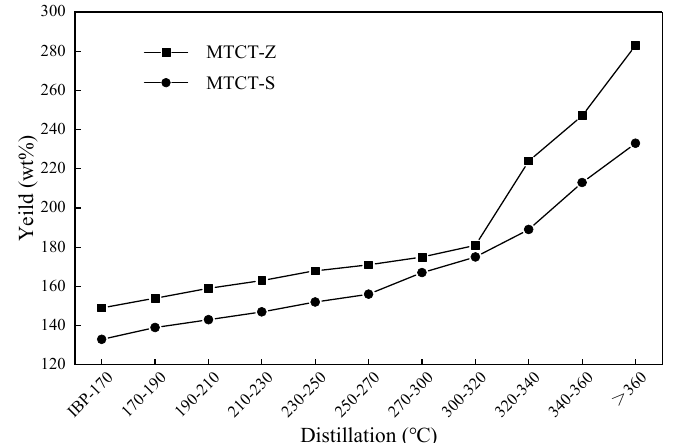
Figure 2. Molecular weight of the distillates.